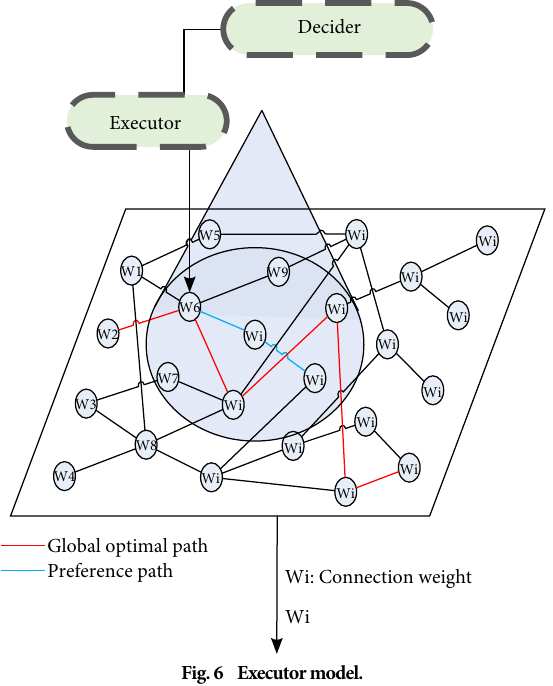
Fig. 6 Executor model.